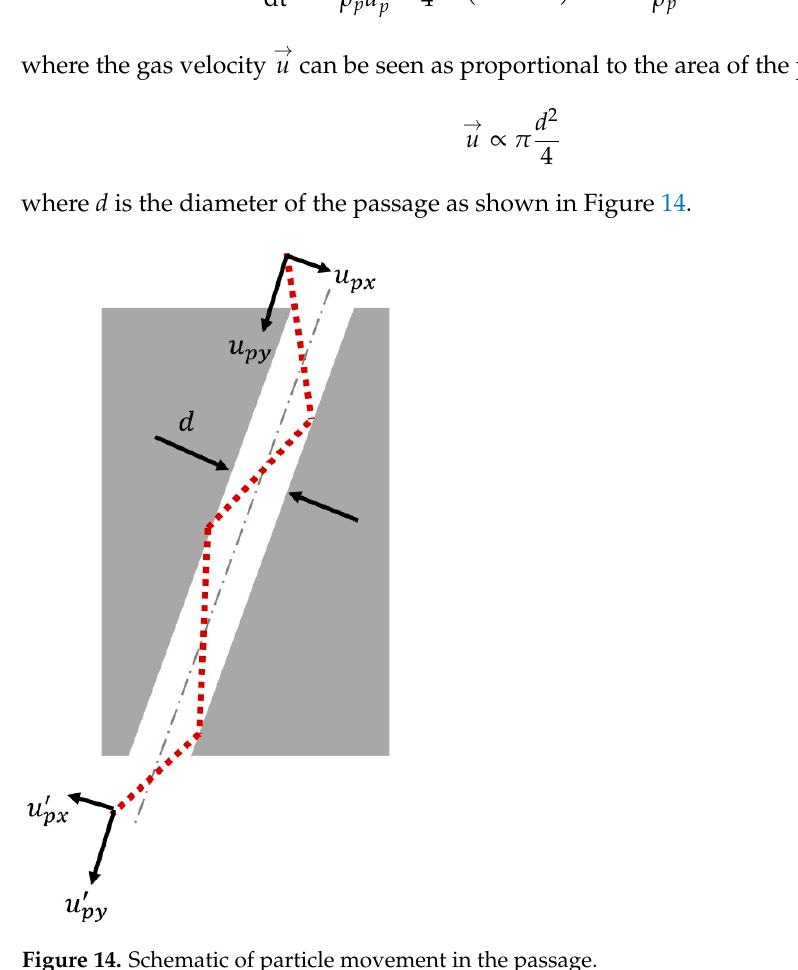
Figure 14. Schematic of particle movement in the passage.